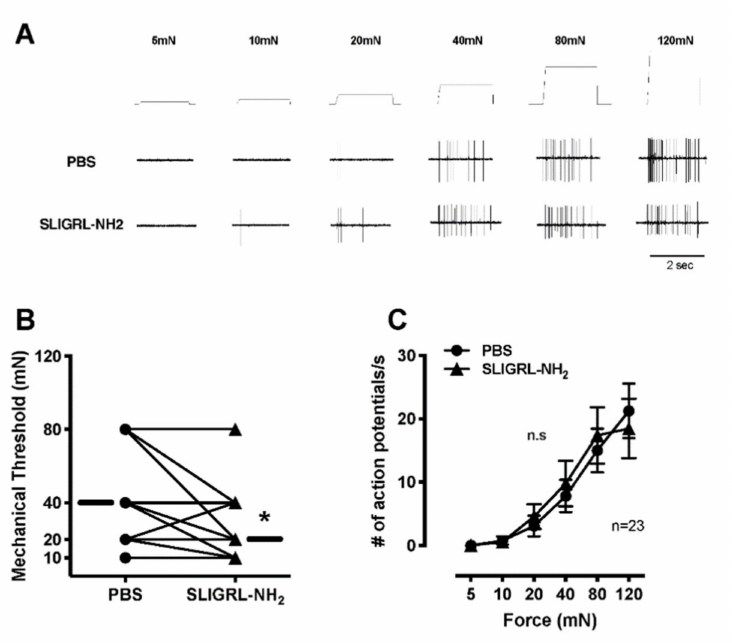
Figure 5. Effects of PAR-2 agonist SLIGRL-NH 2 on mechanical responses of mechanonociceptive C- fibers. Each fiber was tested with application of PBS followed by SLIGRL-NH 2 . ( A ) Example recordings of C-fibers after application of PBS-vehicle and 100 µ M SLIGRL-NH 2 . ( B ) Mechanical thresholds of C-fibers after application of PBS-vehicle and SLIGRL-NH 2 . Each line represents a single unit. The horizontal lines in each graph indicate median values. ( C ) Mechanical stimulus response function of C-fibers after application PBS-vehicle and SLIGRL-NH 2 . Data are presented as means ± SEM. * p <